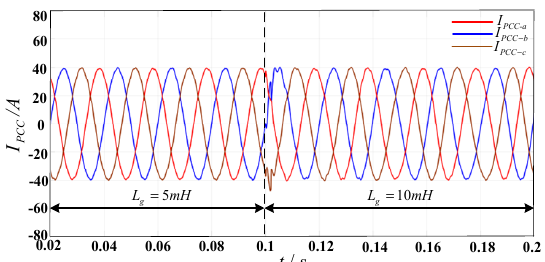
Figure 19. Simulation result of current waveform at PCC after reshaping when the grid-side equiv- alent inductances change.